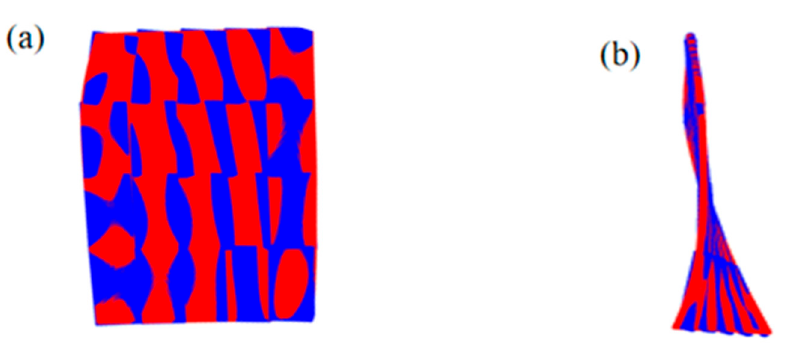
Figure 12. The overall registration effect of each sub-region: ( a ) front view of overall similar surface, ( b ) side view of overall similar surface.